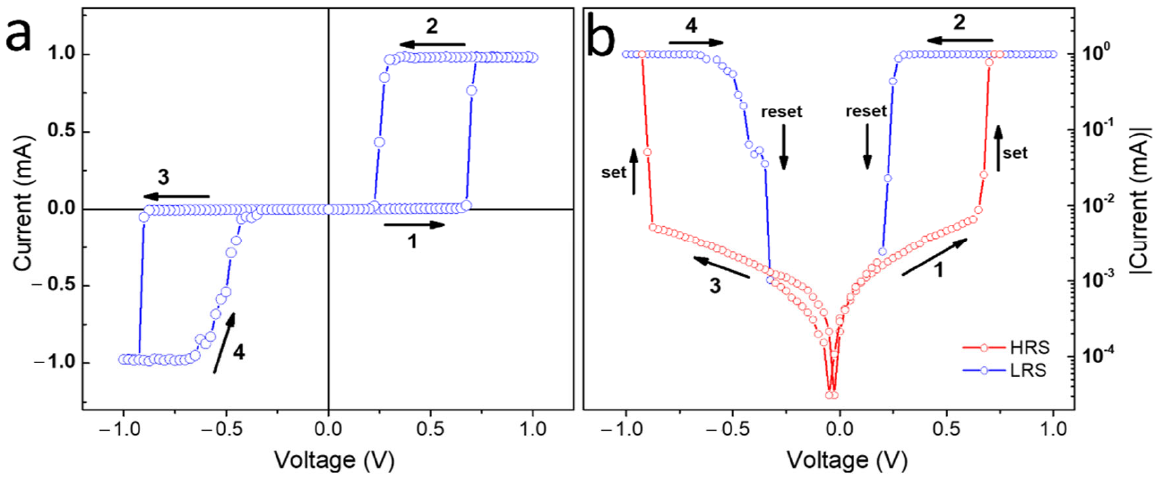
Figure 3. ( a ) I × V hysteresis showing unipolar resistive switching characteristics for the PW thin film. ( b ) Logarithmic plot of absolute current over voltage. The red curve represents HRS and the blue curve LRS.